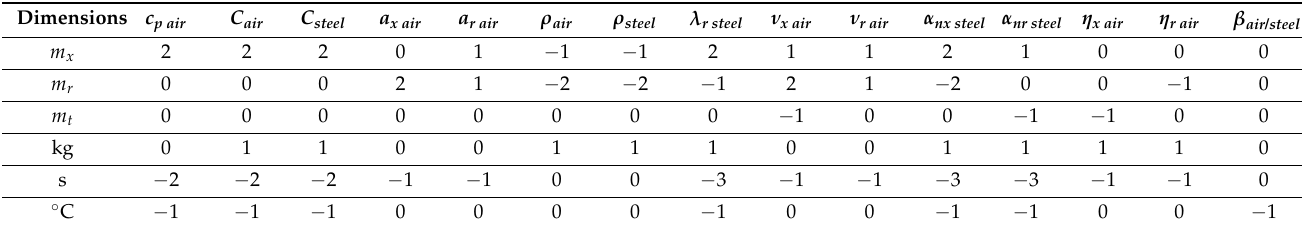
Table 9. The quantities required by the theoretical analysis (part of matrix